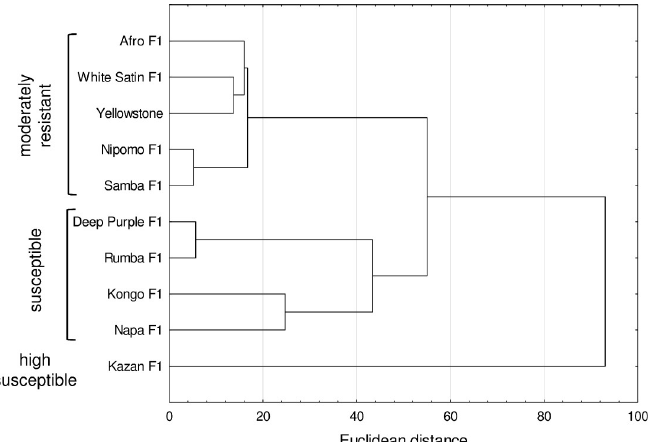
Fig 3. Dendrogram showing the clustering of carrot cultivars based on data obtained from field assessments: Mean number of alates (migrants), mean seasonal number of aphids per plant, mean number of aphids per plant at peak abundance, mean percentage of colonized plants during aphid migration, and mean percentage of colonized plants at peak aphid abundance. https://doi.org/10.1371/journal.pone.0247978.g003 Based on these results, five genotypes with field resistance were identified: Afro F , Nipomo 1 F , Samba F , White Satin F , and Yellowstone, and two highly susceptible genotypes, Kazan 1 1 1 F and Kongo F (Table 2). These two cultivars were the most attractive to hawthorn-carrot 1 1 aphid for colonization; with Kazan F better supporting the development of aphids under field 1 conditions. Specifically, on Kazan F at peak aphid abundance there was a mean of 56.7 aphids 1 per plant, which was more than 2.5 times the number on Kongo F (21.0 aphids per plant) in 1 2012 (Fig 1F). In addition, Deep Purple F , Napa F and Rumba F were classified as suscepti- 1 1 1 ble to the hawthorn-carrot aphid (Table 2). There were significant differences among the studied carrot genotypes with respect to the length, thickness, and density of leaf and leaf petiole trichomes (Table 3). The longest